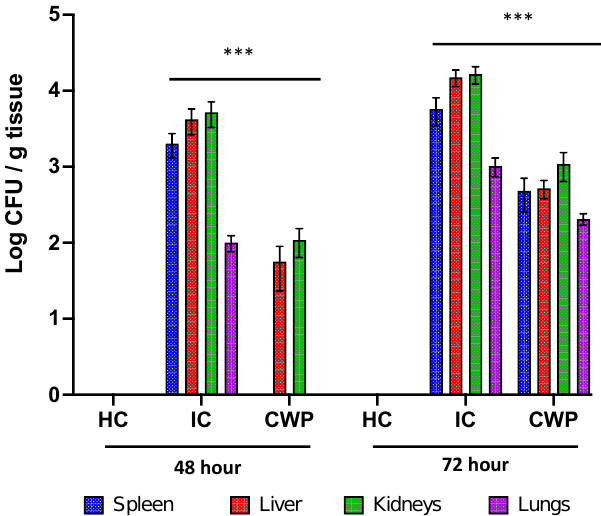
Figure 3. Analysis of fungal burden. The effect of cell wall protein extract against infection caused by C. parapsilosis . The fungal burden was expressed as geometric means of logarithmic values for CFU/mg of tissues. HC = health control; CWP = cell wall protein; IC = infection control. (*** p < 0.05).